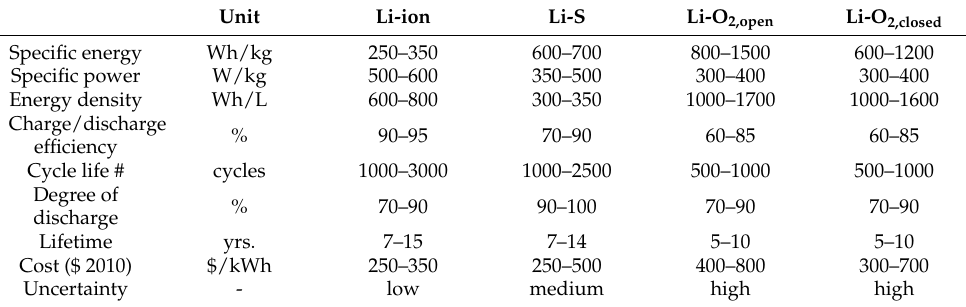
Table 4. Trends in future batteries at cell level by year 2035